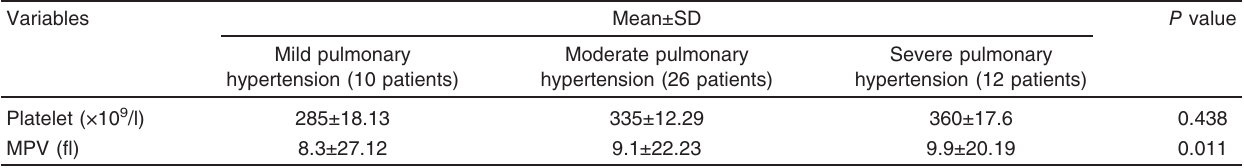
Mild (PASP = 35 – 50), moderate (PASP = 50 – 70), and severe PH (PASP > 70). MPV, mean platelet volume; PASP, pulmonary artery systolic pressure; PH, pulmonary